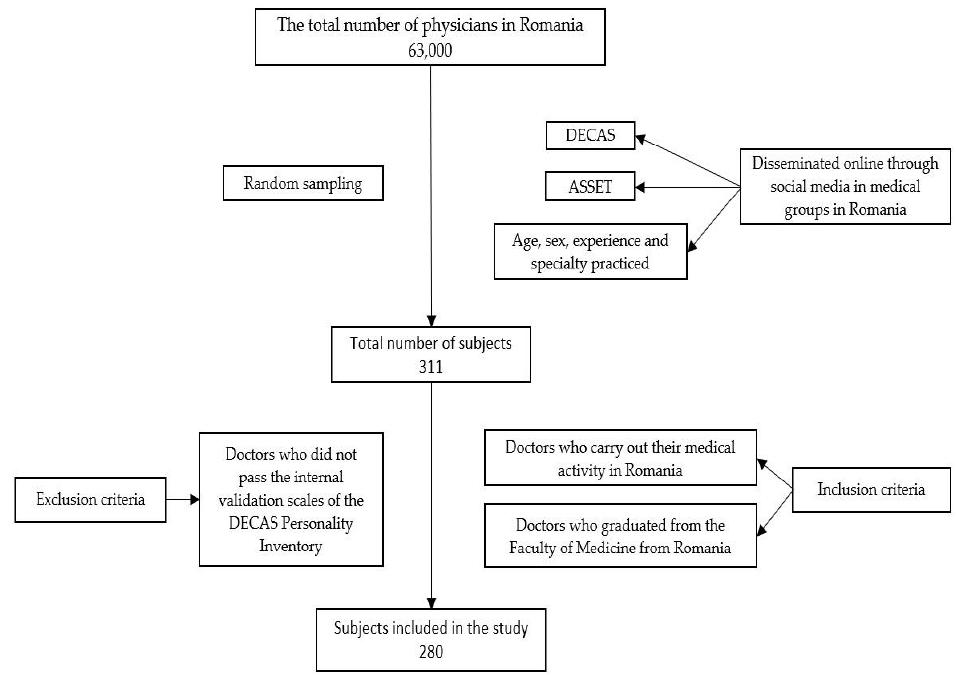
Figure 1. Participants and Procedure.